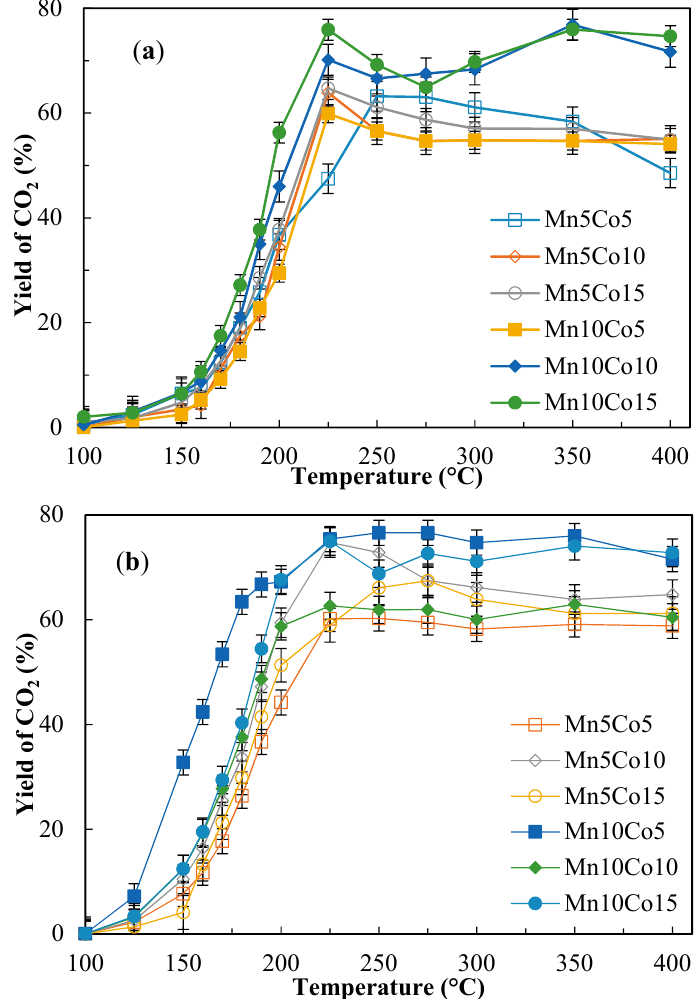
Figure 7. Average yields of CO 2 achieved over three runs on ( a ) Mn x Co y /N, ( b ) Mn x Co y /F during the light-off experiments.